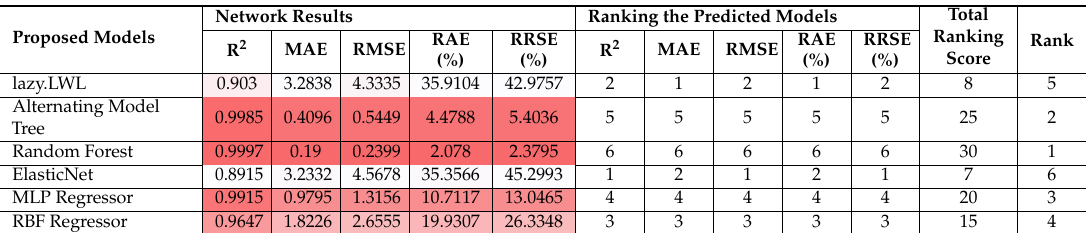
Table 3. The performance of selected machine learning techniques in the prediction of heating load through several statistical indexes (training dataset).